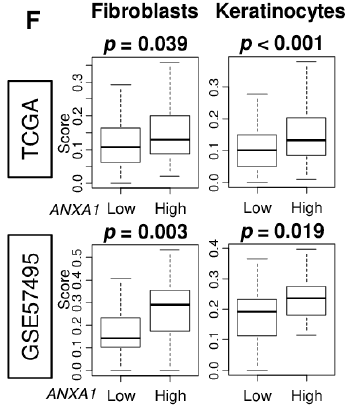
Figure 1. Association of Annexin A1 ( ANXA1 ) expression with epithelial–mesenchymal transition (EMT), angiogenesis, and stromal cells in The Cancer Genome Atlas (TCGA) and GSE57495 cohorts. ( A ) Scatter plots of ANXA1 expression with the EMT score. ( B ) Boxplots of EMT-associated gene expression: cadherin1 ( CDH1 ) and CDH2 , snail family transcriptional repressor 1 ( SNAI1 ) and SNAI2 , and twist-related protein 1 ( TWIST1 ) by ANXA1 low and ALXA1 high pancreatic cancer (PC). ( C ) Scatter plots of ANXA1 expression with the angiogenesis score. ( D ) Boxplots of infiltrating fraction of endothelial cells, microvascular endothelial (mvE) cells, and lymphatic endothelial (lyE) cells by ANXA1 low and ANXA1 high PC. ( E ) Boxplots of angiogenesis-associated genes expression: platelet and endothelial cell adhesion molecule 1 ( PECAM1 ) and sphingosine-1-phosphate receptor 1 ( S1PR1 ) by ANXA1 low and ANXA1 high PC. ( F ) Boxplots of the infiltrating fraction of fibroblasts and keratinocytes by ANXA1 low and ANXA1 high PC. Median cut-off within each cohort was used to divide them into ANXA1 low and ANXA1 high groups ( n = 88, respectively, in the TCGA and n = 31 and 32, respectively, in the GSE57495 cohort). Spearman’s rank correlation was used for